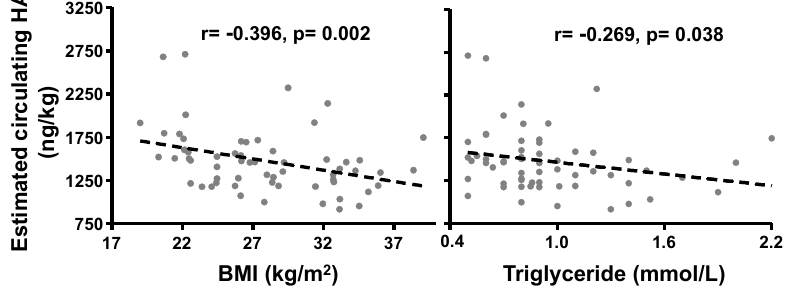
Figure 5. Negative correlations of estimated circulating HA per adipose tissue and BMI/triglyceride. The scatterplot showing the relationship between blood volume-adjusted circulating HA (ng/kg) and BMI (kg/m 2 ), or triglyceride (mmol/L). Statistically significant Spearman’s correlations have shown between baseline characteristics and circulating HA.